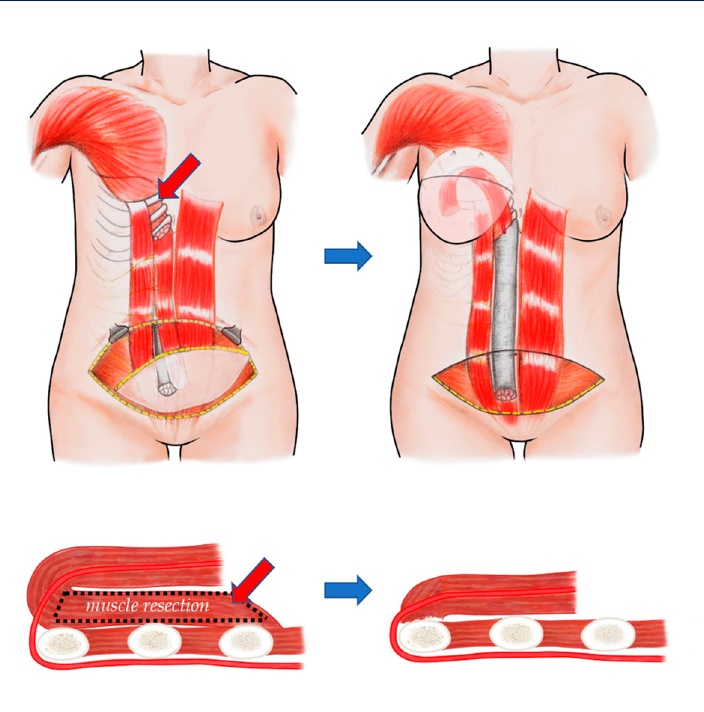
Figure 6. Schematic drawing of rectus muscle resection and flap transposition. ( Top left ) The area from which the rectus muscle was removed is marked by the red arrow. ( Top right ) After transposition of the pedicled TRAM flaps. ( Bottom ) A cross ssectional view of the area where the rectus muscle was transpositioned, the left side was when the muscle was not excised and the right side was when the muscle (red arrow) was resected. The height decreases as much as the width of the resected muscle, so the pedicle is subject to less pressure and epigastric bulging is